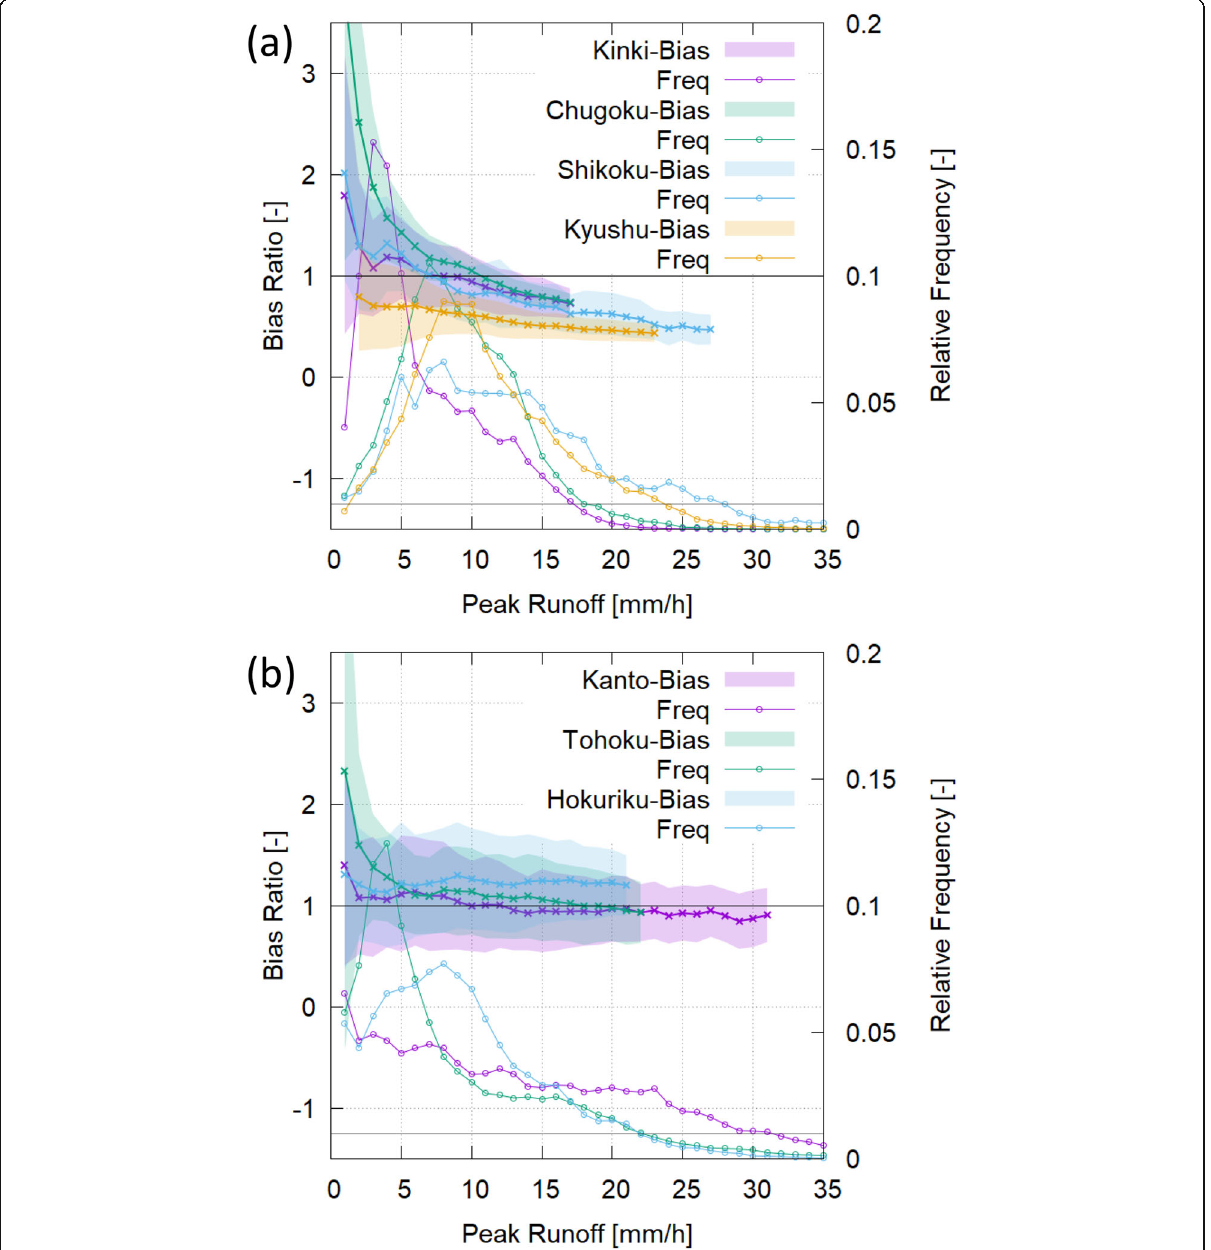
Fig. 8 The mean and standard deviation of bias in the forecasted peak runoff compared to the simulated one for a F18 and b T19. The BI is computed depending on the peak runoff shown in x -axis. The dotted lines without the shading show the relative frequency of the simulated peak